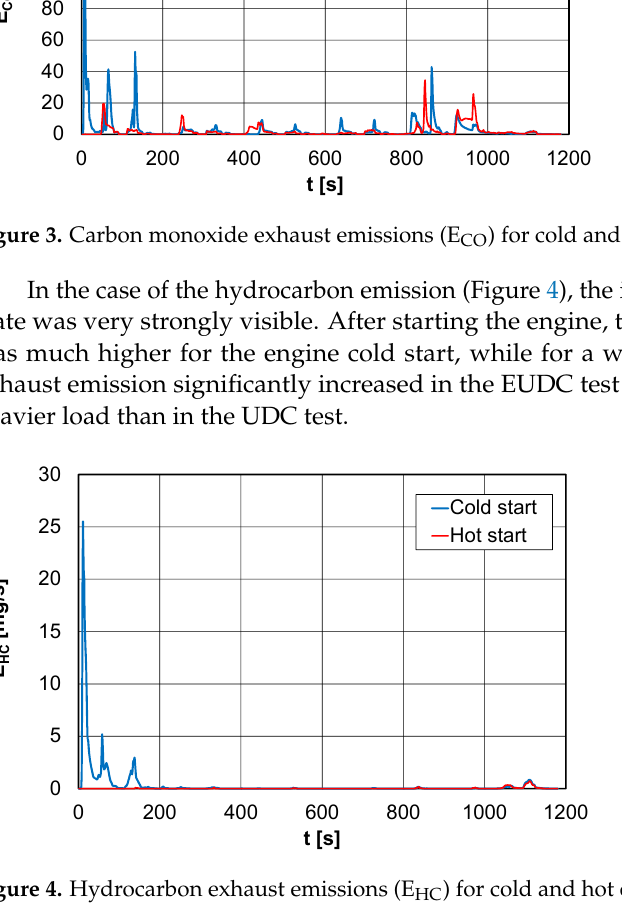
much lower. At the same time, the particle number was higher for the hot engine start ‐ up in the EUDC test, i.e., under high engine load conditions.